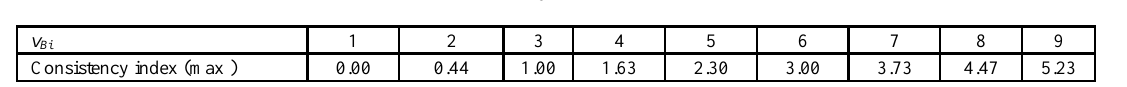
Table 2 is used to get the value of the consistency index (Rezaei, 2015). Table 2. Consistency index table for